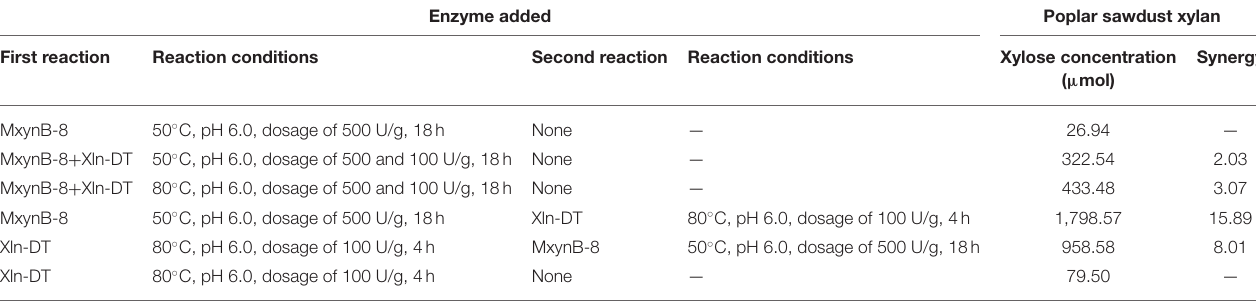
TABLE 4 | Simultaneous or sequential hydrolysis reactions by endo-1,4- β -xylanase MxynB-8 and β -xylosidase Xln-DT against poplar sawdust xylan substrate. Enzyme added